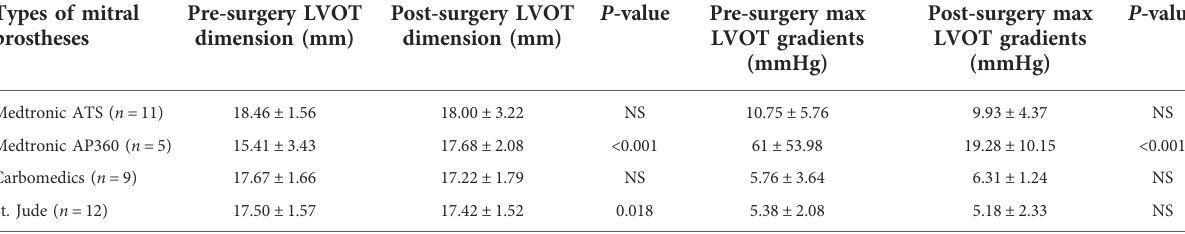
TABLE 2 Mitral prosthesis and LVOT dimension in re-do MVR patients. Types of mitral